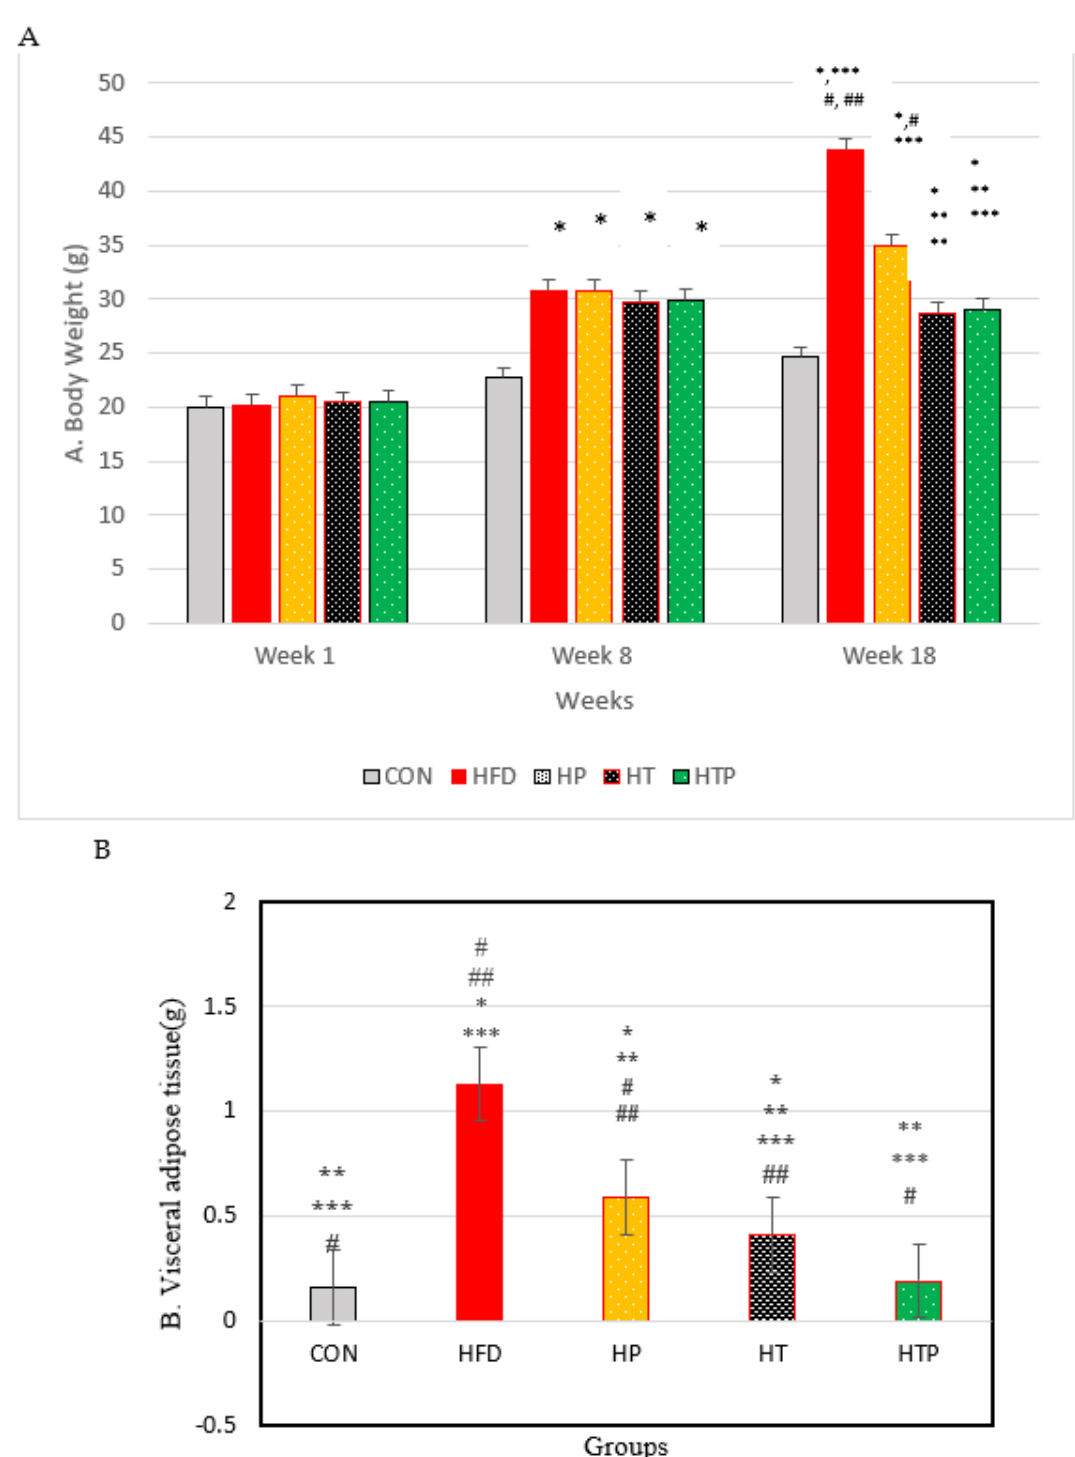
Figure 1. ( A ): Bodyweight of C57BL/6 mice (Mean ± SE) in experimental group, Week 1: first weights, Week 8: following 8 weeks of interventions (high- fat diet in 4 groups and normal diet in 1 group), Week 18: following 8 weeks of interventions (HIIT training and/or probiotic supplementation). ( B ): Comparison of the VFM of C57BL/6 mice (Mean ± SE) in experimental groups. * p < 0.05: significant difference with CON group; ** p : significant difference with HFD; *** significant difference with HP group; #: significant difference with HT group; ##: significant difference with HTP group; CON: control, HFD: high-fat diet, HP: high-fat diet+ probiotic, HT: high-fat diet +HIIT training, HTP: high-fat diet+ HIIT training+ probiotic.